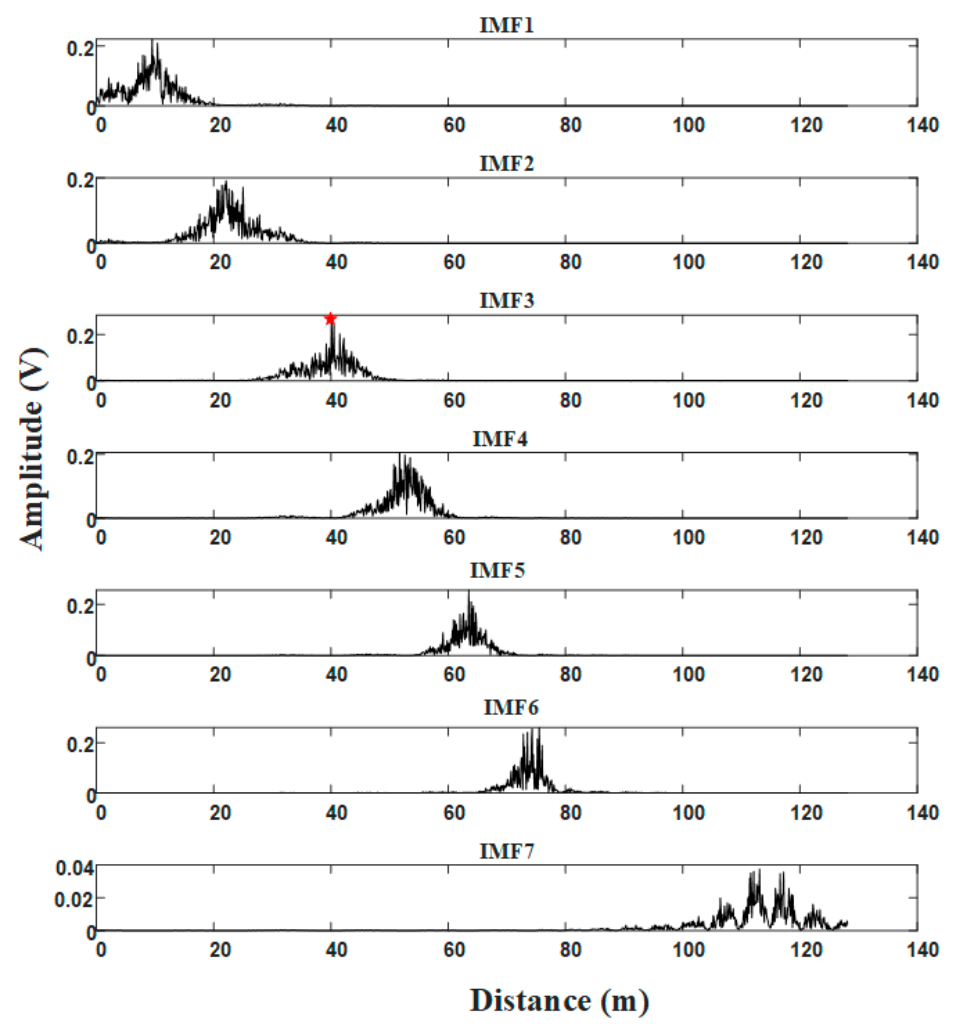
9 of 19 Figure 4. Optimization process of the WOA.